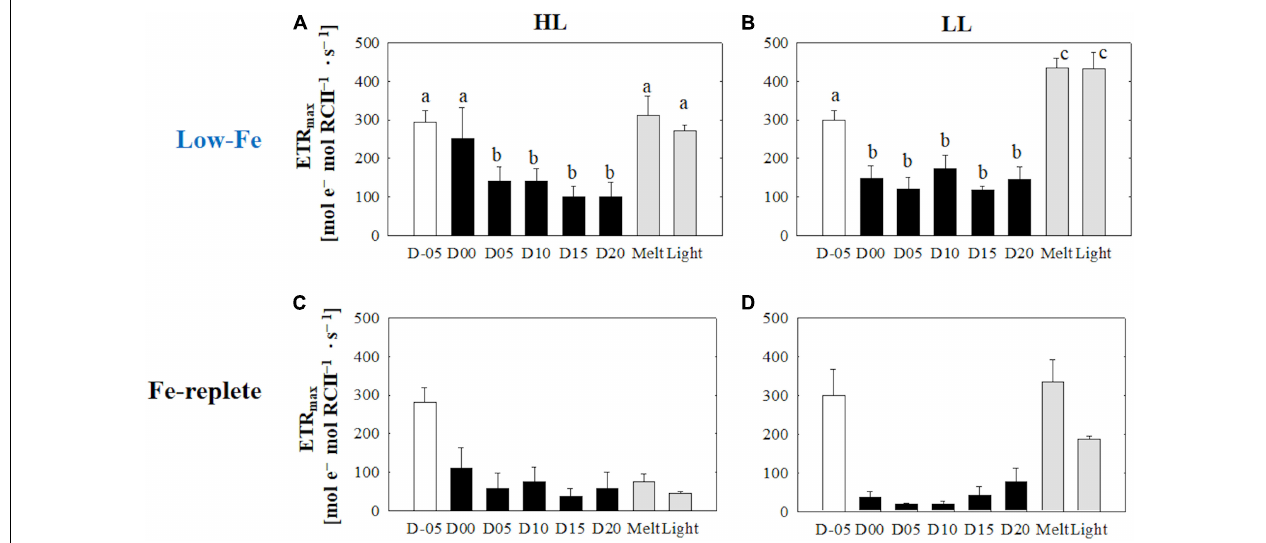
FIGURE 7 | Maximum electron transport rate (ETR max ) calculated from the photosynthesis-irradiance (ETR RCII - E ) relationship at each sampling time point during the ice tank incubation experiments. Panels (A,B) show ETR max values of the low-Fe ice tank runs in this study, whereas panels (C,D) show those of Fe-replete ice tank runs modified from Yoshida et al. (2020). Left (A,C) and right (B,D) panels indicate data from the HL and LL treatments, respectively. Open, closed, and shaded bars indicate values of pre-freeze seawater, ice, melted seawater samples, respectively. Letters above bars in a panel indicate significant differences in values between sampling days with one-way ANOVA with Tukey’s test; there is no significant difference between values if a given letter is shown in the combination of letters of the counterparts. The D stands for “day,” while Melt and Light indicate values after melting and light exposure experiments, respectively. Error bars show 1 standard deviation ( n = 6). One-way ANOVA with Tukey’s test, HL: F ( 7 , 47 ) = 25.85, p < 0.001; LL: F ( 7 , 47 ) = 118.16, p < 0.001. Two-way ANOVA test with Tukey’s test, Light: F ( 1 , 90 ) = 10.09, p > 0.05; Day: F ( 7 , 90 ) = 35.07, p < 0.001; Light*Day: F ( 7 , 90 ) = 6.36, p < 0.001. A significant interaction between the light availabilities and sampling time points was observed. The results of Tukey’s test, as q -values, are given in the